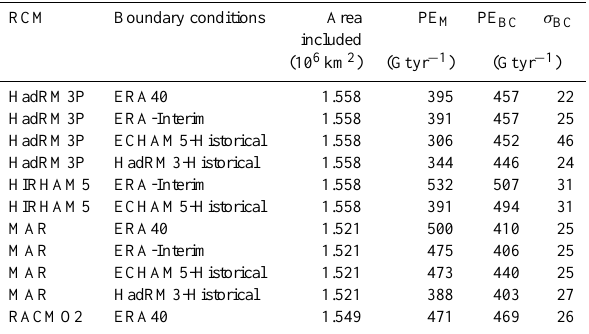
Table 4. Area-integrated PE M , PE BC and σ BC over entire area in- cluded in analysis (north of the blue line in Fig.